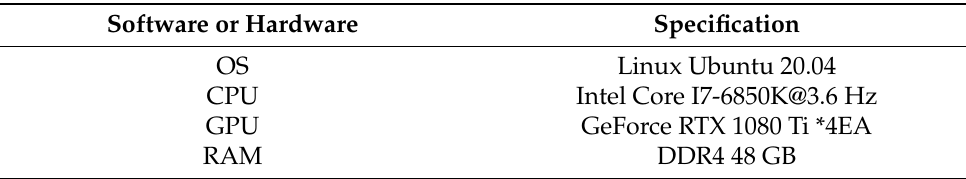
Figure 3. The process of creating an avoidance route for VAF. When the drone takes off, the drone receives data in real-time, then transmits the data to the flight controller. Following that, we use our filtering method to remove the small-sized objects, which may cause the the detecting time to become slower, then detect the object and create an avoidance route. Table 1. Workstation configuration for the